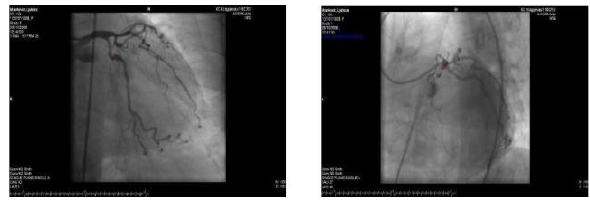
Figure 2. Images from